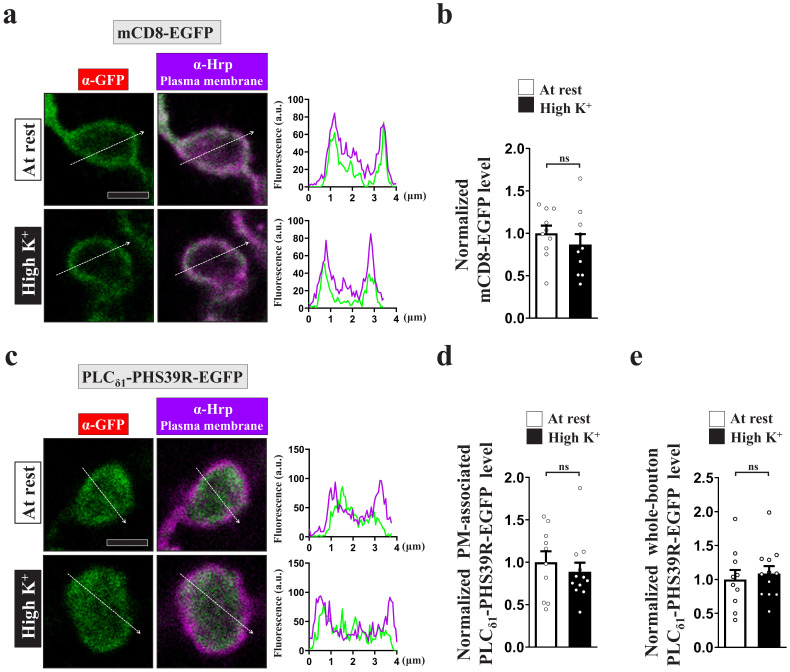
The distribution of mCD8-EGFP and PLCδ1-PHS39R-EGFP remains unchanged upon intense stimulation.Single-plane confocal images of NMJ boutons neuronally expressing UAS-mCD8-EGFP (a) or UAS-PLCδ1-PHS39R-EGFP (c) using nSyb-GAL4. The boutons were subjected to the resting condition (10 min incubation of 5 mM K+/0 mM Ca2+) or high K+ stimulation (10 min stimulation of 90 mM K+/2 mM Ca2+), followed by chemical fixation and α-GFP immunostaining. Line plot profiles of absolute fluorescence units (a.u.) of α-GFP immunostaining signal of both probes are shown at right. α-Hrp immunostaining (magneta) was used to outline the presynaptic plasma membrane. mCD8-EGFP (green) was exclusively localized in the plasma membrane, whereas PLCδ1-PHS39R-EGFP (green) was mainly expressed in the cytosol. Quantification data for immunostaining intensities of the plasma membrane-associated mCD8-EGFP (b), the plasma membrane-associated PLCδ1-PHS39R-EGFP (d), or the whole-bouton PLCδ1-PHS39R-EGFP (e), normalized to the value of the resting condition. Individual data values are shown in graphs. p values: ns, not significant. Mean ± SEM. Scale bar: 2 µm (a, c). Statistics: Student t-test.
Figure 1—figure supplement 2—source data 1.Source data for Figure 1—figure supplement 2.